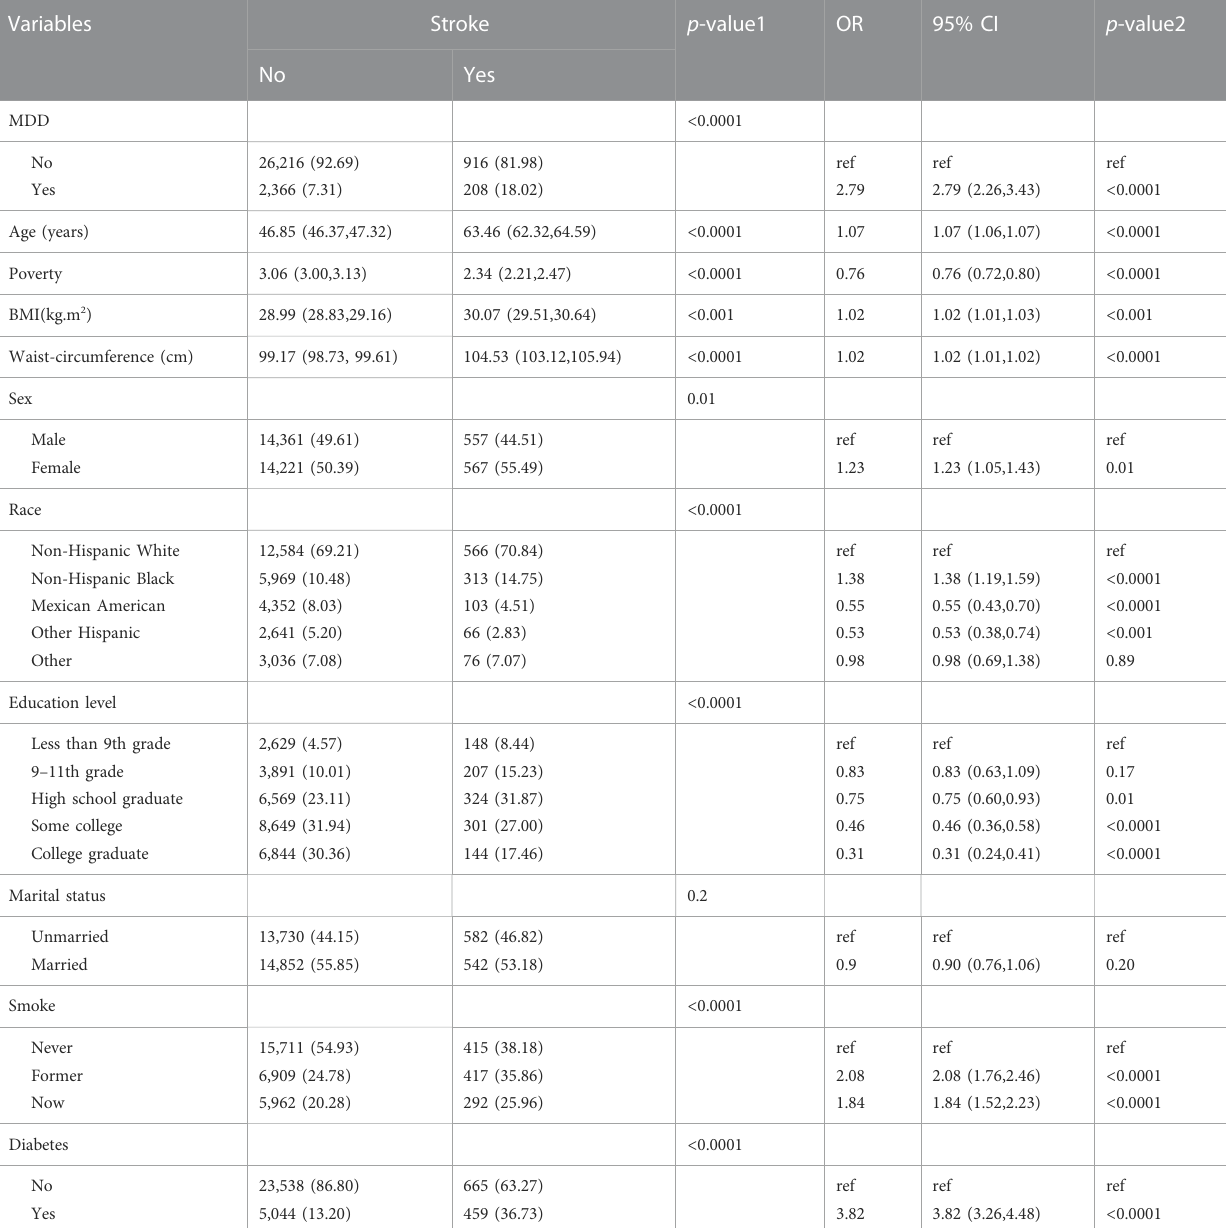
TABLE 1 Baseline characteristics and odds ratio of participants by stroke levels in NHANES (2005 – 2018). Variables Stroke p